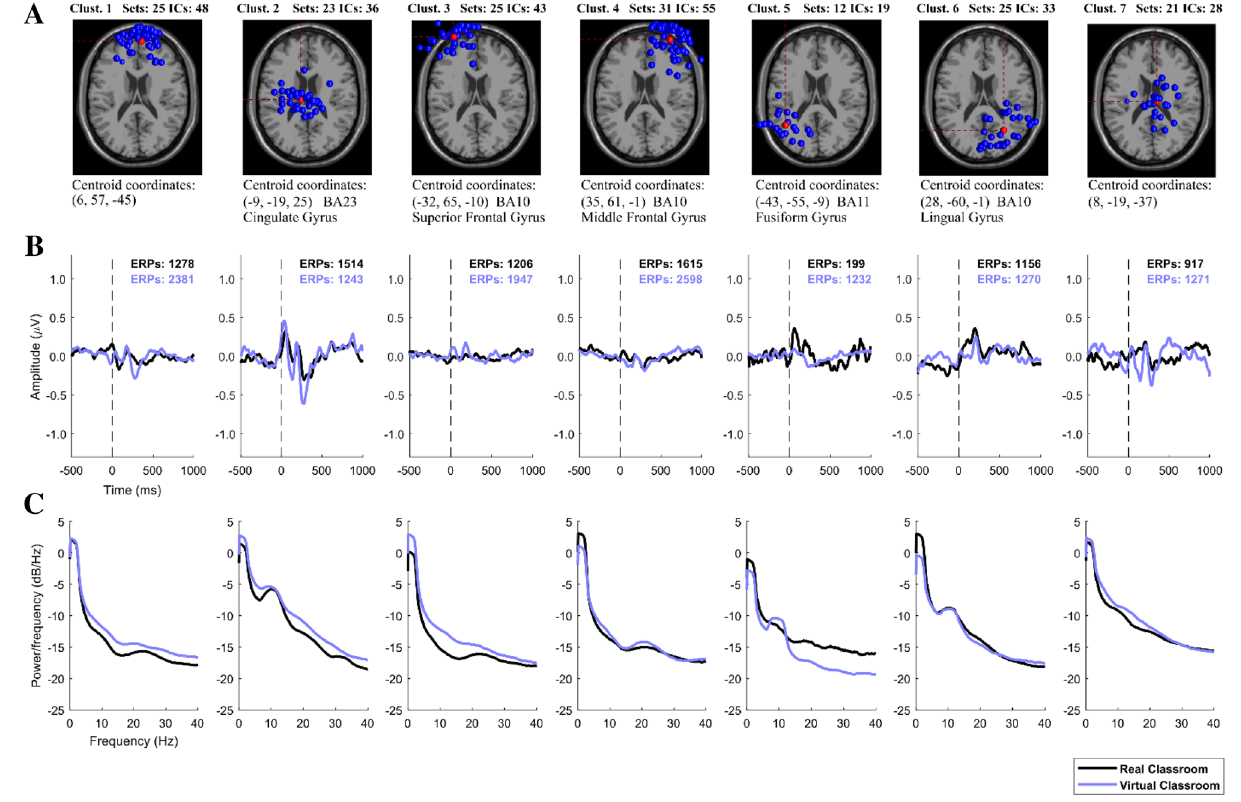
Figure 4. EEG group data analysis for equivalent dipoles corresponding to the ICs from all participants, in the real-world environment vs. the virtual environment. Seven IC clusters were obtained, indicated as Clust. 1–7, with their data shown in each column. ( A ) Projected equivalent dipole locations. ( B ) ERP waveforms obtained from the corresponding correct-response inputs. ( C ) ERP Power spectral density, averaged for each